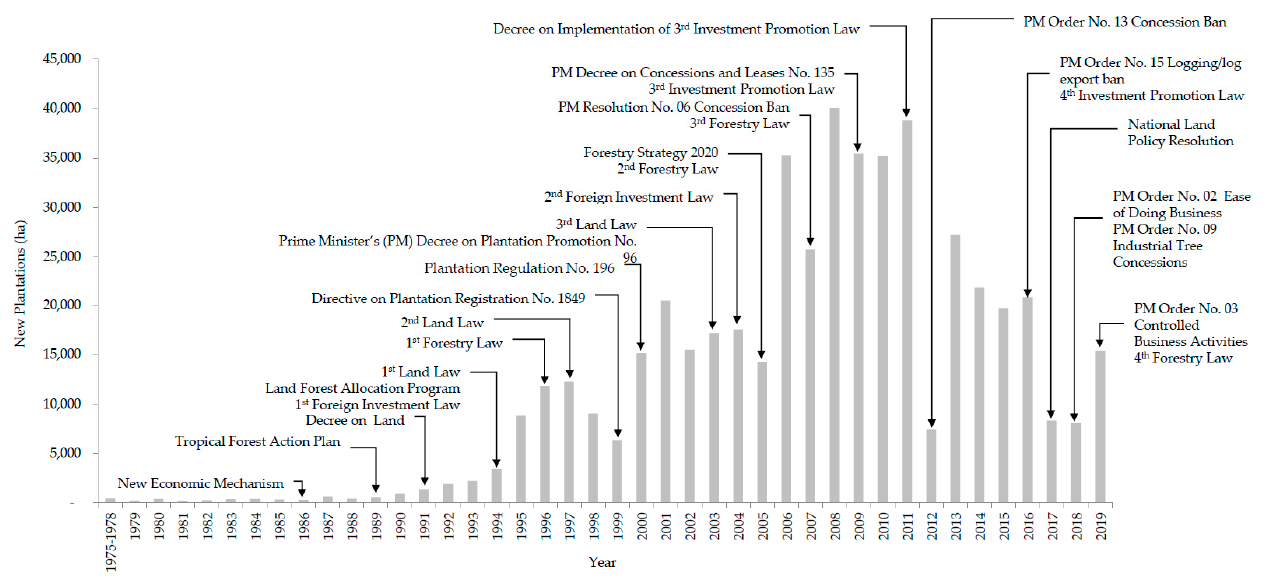
Figure A1. Policies and Plantation Establishment in Laos 1975–2019.